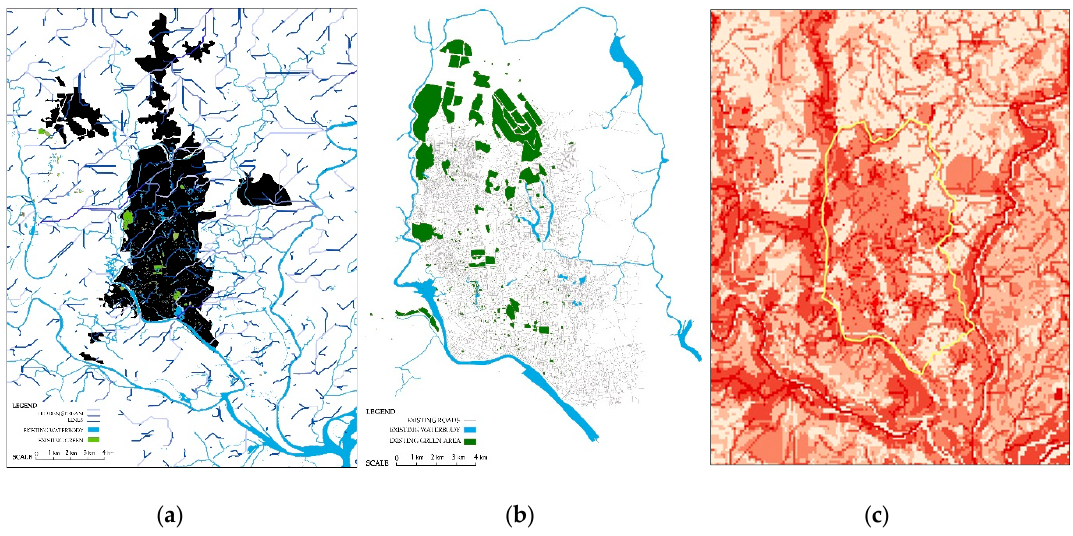
Figure 7. ( a ) Hidden streams and existing water network. ( b ) Existing green areas. ( c ) Suitable locations for green stormwater infrastructure (darker red represents highly suitable areas). for green stormwater infrastructure (darker red represents highly suitable